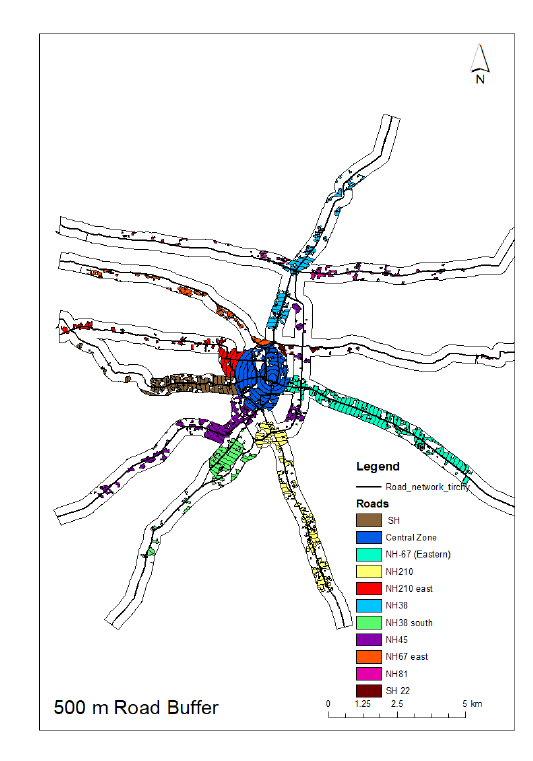
Figure 2. 500m buffer along the roads Shannon’s entropy ( H n ) is used to measure the degree of spatial concentration or dispersion of geophysical parameter among the n zones. It is given by equation (1)